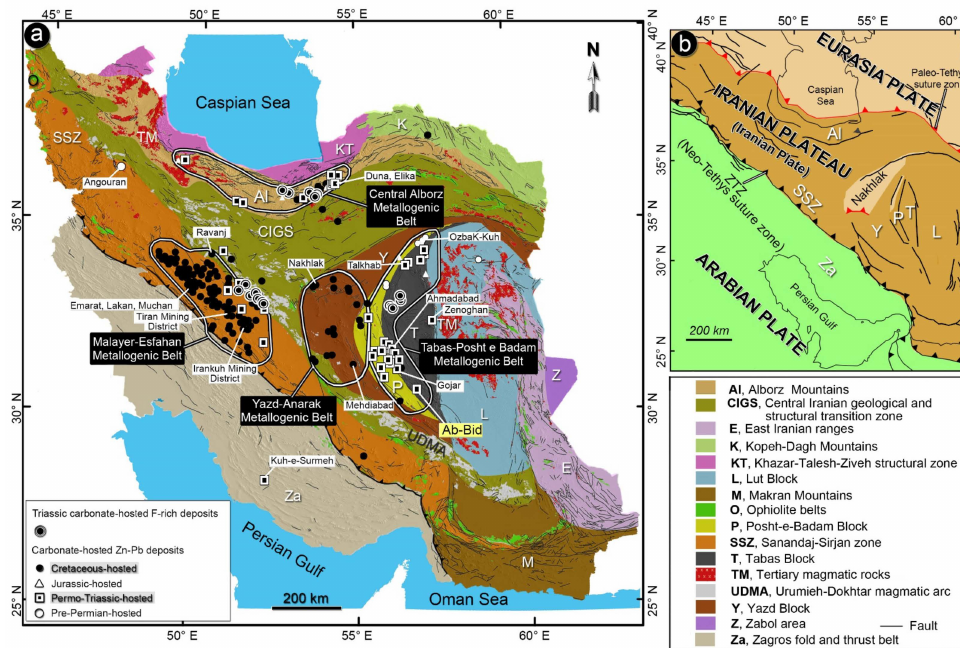
Figure 1. ( a ) Simplified tectonic map of Iran [5,10] and distribution map of carbonate-hosted (CH) Zn-Pb and F-rich deposits according to the age of host rocks in the Central Alborz, Tabas-Posht e Badam, Malayer-Esfahan, and Yazd-Anarak metallogenic belts [3,4]. Those in Permo-Triassic rocks include MVT deposits, but the Cretaceous-hosted deposits include Early Cretaceous Irish-type Zn–Pb and some MVT deposits [2]. ( b ) Simplified terrane map of the western Tethysides [5]. Note the location of the Iranian Plateau between the Arabian and Eurasia (Turan)